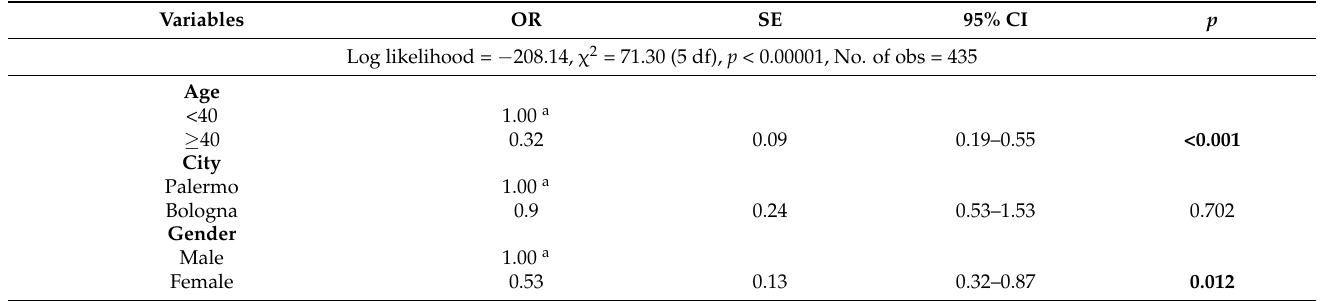
Table 3. Multivariate logistic regression model of determinants for Vaccine Confidence.